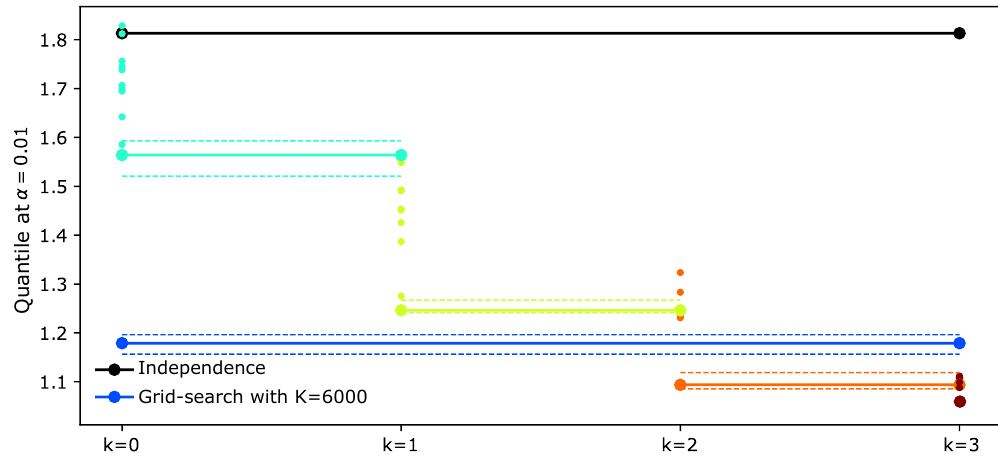
Figure 7: Minimization of the output quantile using a grid-search and the iterative procedure for α = 1% . The description is the same as in Figure